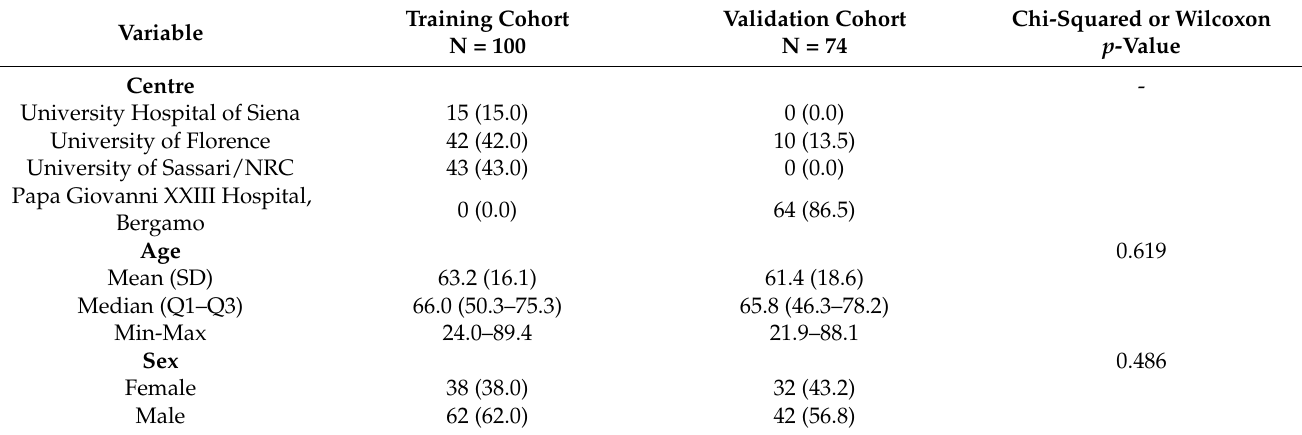
Table 1. Demographic and clinical